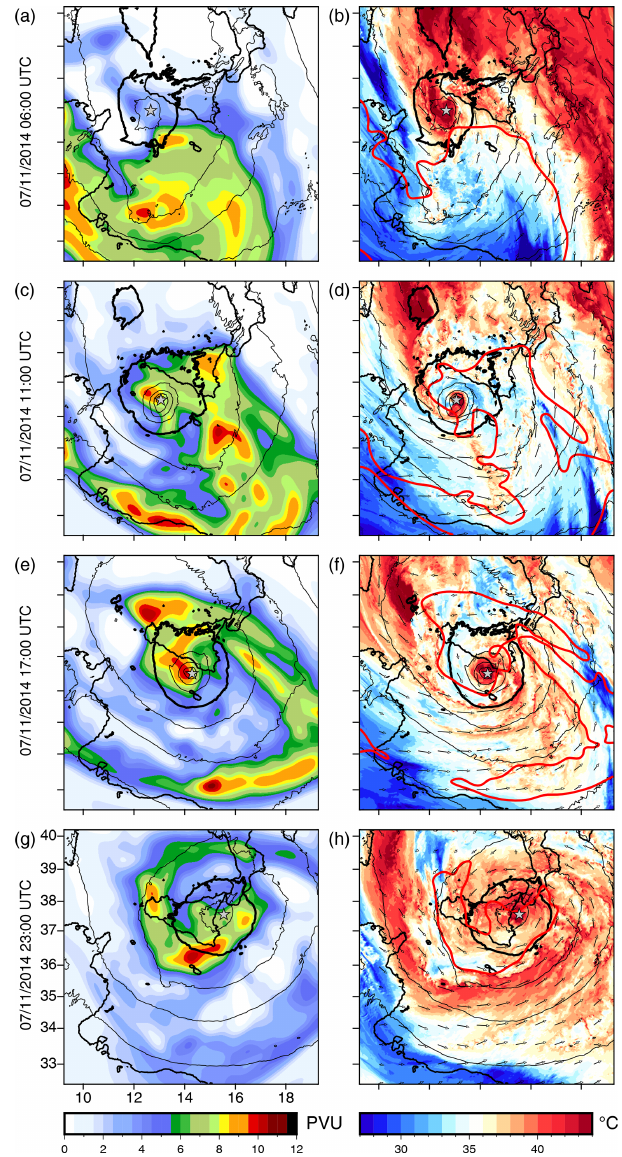
Figure 5. Potential vorticity at 300hPa (colour scale) and SLP (isocontours every 4hPa; the 1000hPa isobar is in bold) (a, c, e, g) and equivalent potential temperature ( ◦ C; colour scale) and wind at 850hPa, SLP, and 6PVU at 300hPa isocontours (red) (b, d, f, h) from the NOCPL